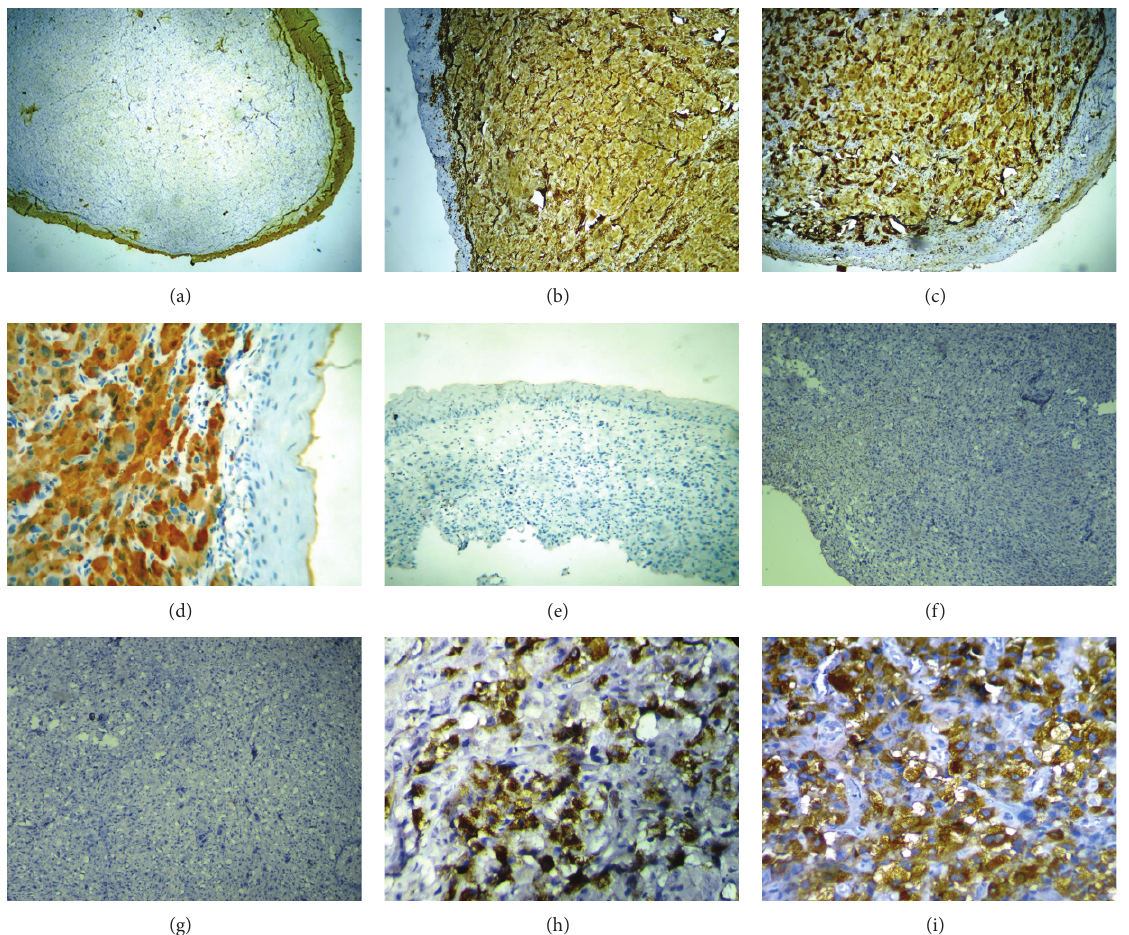
Figure 4: (a) Immunohistochemistry for pan cytokeratin showing no expression in tumour cells (5x). (b) Immunohistochemistry for desmin showing diffuse positivity (10x). (c) Immunohistochemistry for vimentin (diffusively positive (10x)). (d) Immunohistochemistry for S100 showing diffusenuclear and cytoplasmic expression (40x). (e) Immunohistochemistryfor CD68 (negative, (10x)). (f)Immunohistochemistry for neuron-specific enolase (negative, (10x)). (g) Immunohistochemistry for myoglobin (negative, (5x)). (h) Immunohistochemistry showing positivity for HMB-45 (40x). (i) Immunohistochemistry for Melan-A; granular localization is observed in the cytoplasm